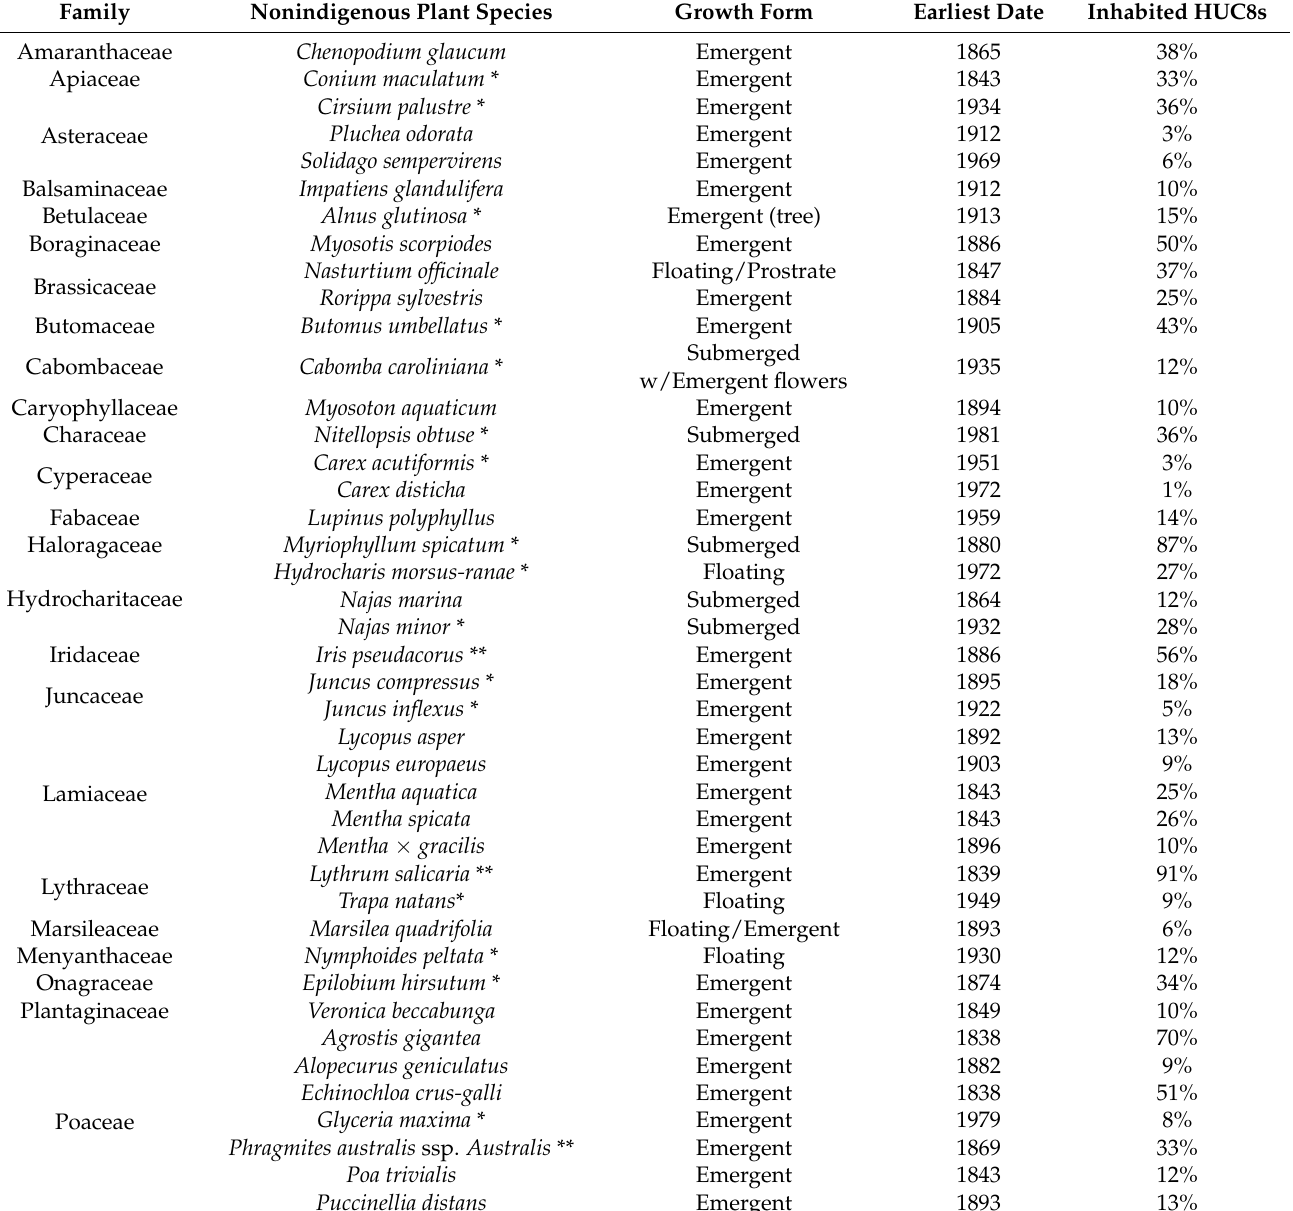
Table 1. Great Lakes nonindigenous aquatic plants included in the Great Lakes Aquatic Nonindigenous Species Information System (GLANSIS). Total plant species included = 55 (of 188 total nonindigenous species). The date range for all records in the database spans 1709–2019, with the first plant introduction dated to 1837. Total hydrologic units (HUC8s) in the basin = 105. Source: [22]. * noticeable stress, ** significant adverse